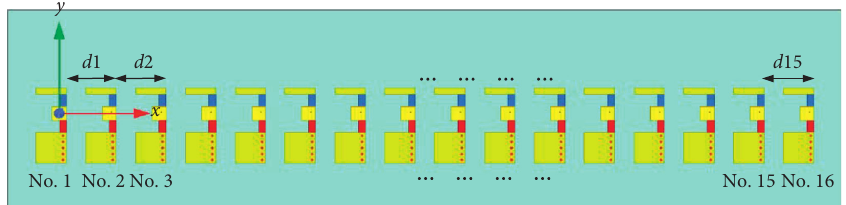
Figure 13: The schematic of the 1 × 16 linear uniform FRAA.